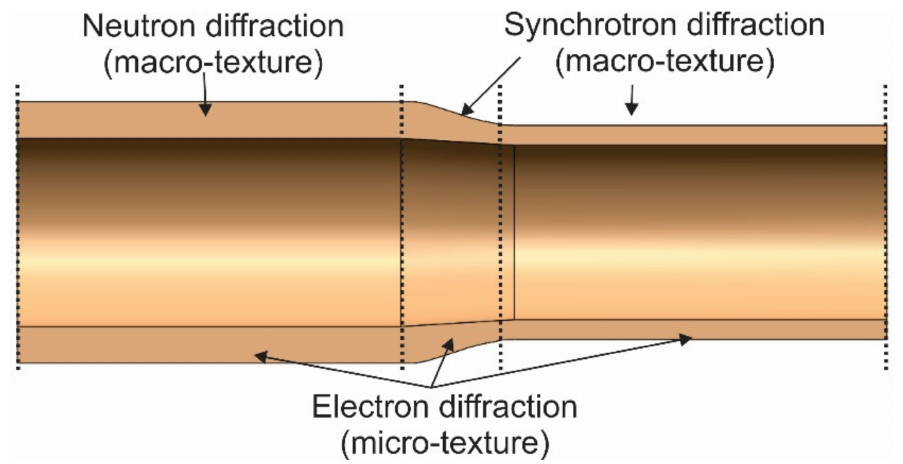
Figure 3. The interrupted drawn tube IDT used for texture measurements. Samples were taken from the as-received and the drawn tubes without and with tilting angles of ± 5 ◦ at three positions of max and min to be evaluated for texture